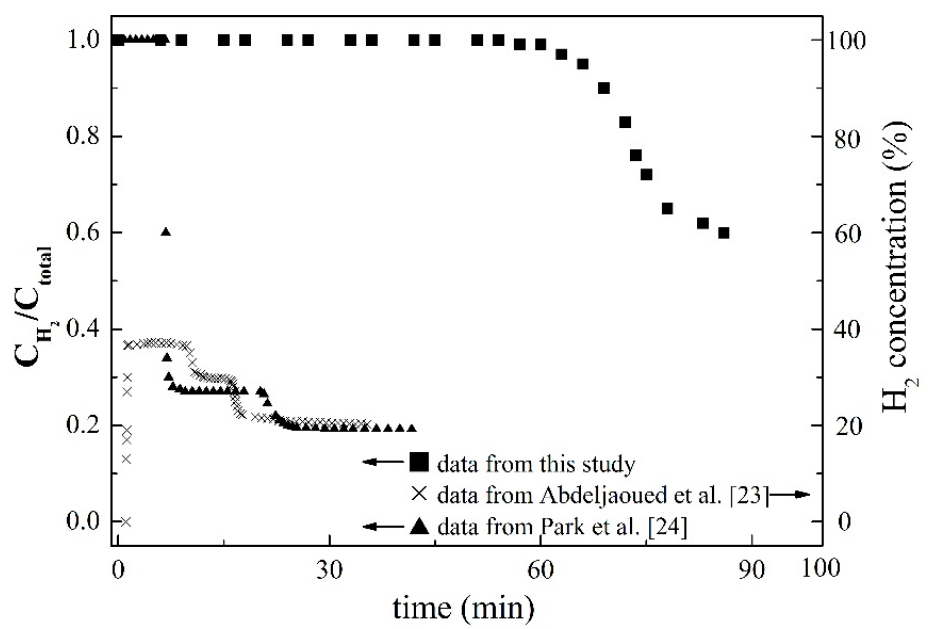
Figure 5. The breakthrough curve compared with literature data.